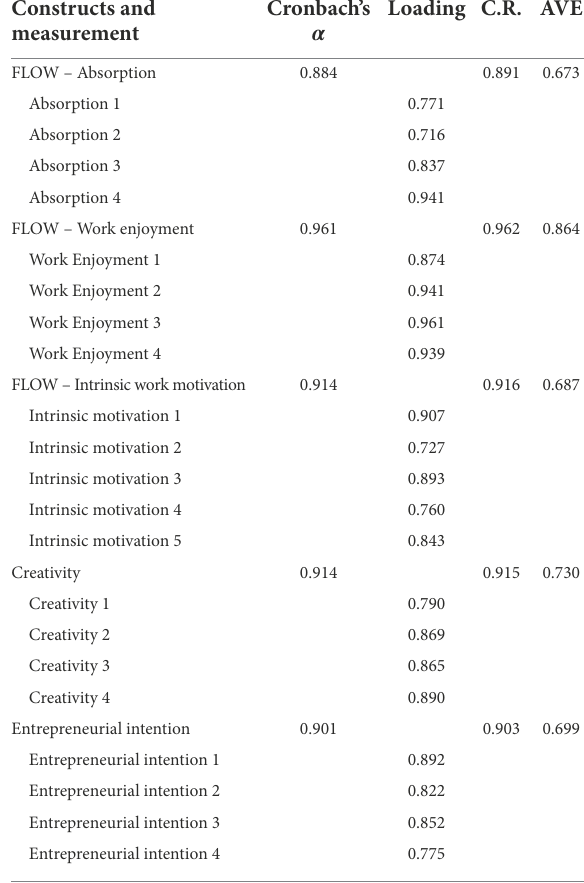
TABLE 4 Construct measurements, reliability and validity. TABLE 3 Descriptive analysis of five